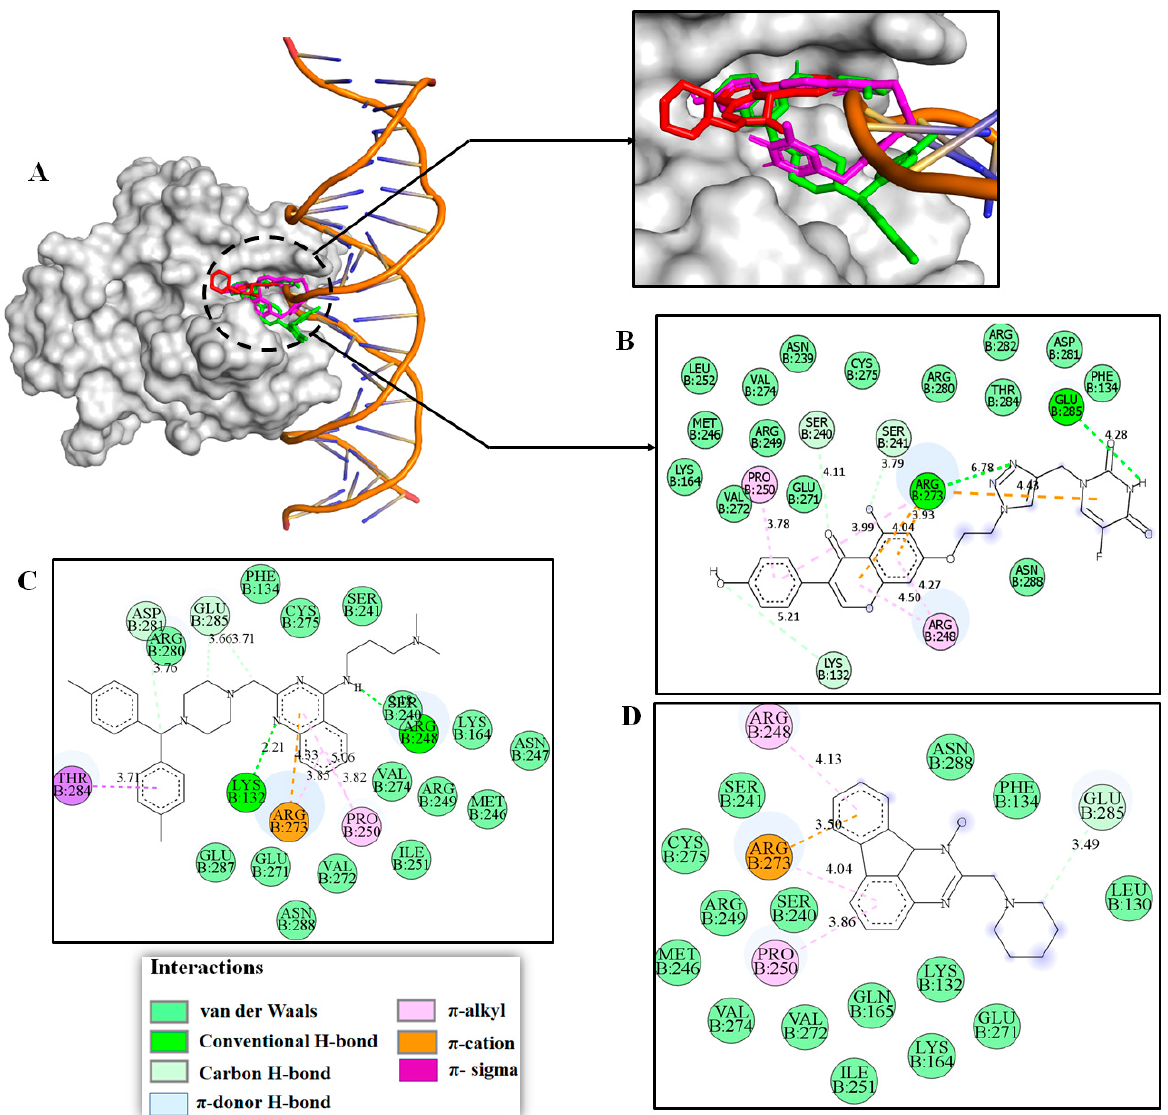
Figure 11. Docking studies of 4a-p53 complex. ( A ) 3D superposition of the best-docked pose of p53-modulators SCH529074 (in green), NSC194598 (in red), and 4a (in magenta) into the open L1/S3 pocket of p53. ( B ) 2D interaction plot between 4a and p53 protein. ( C ) 2D interaction diagram during SCH529074-p53 binding. ( D ) 2D interaction diagram during NSC194598- p53 binding.